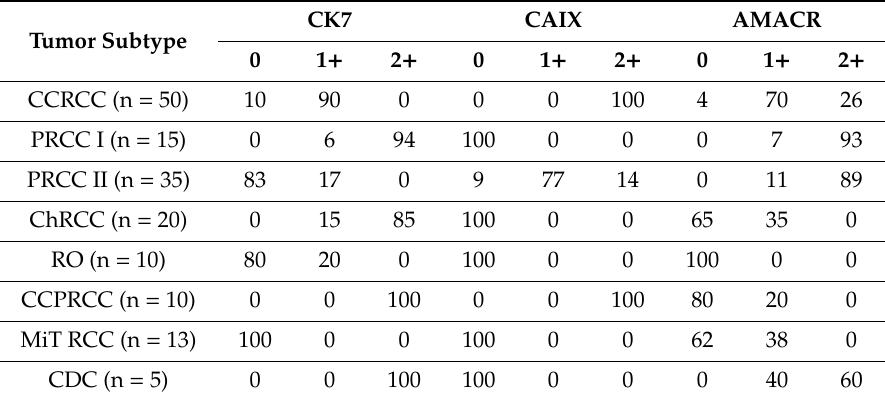
Table 2. Triple immunomarkers as the first trial panel in RCC subtyping.